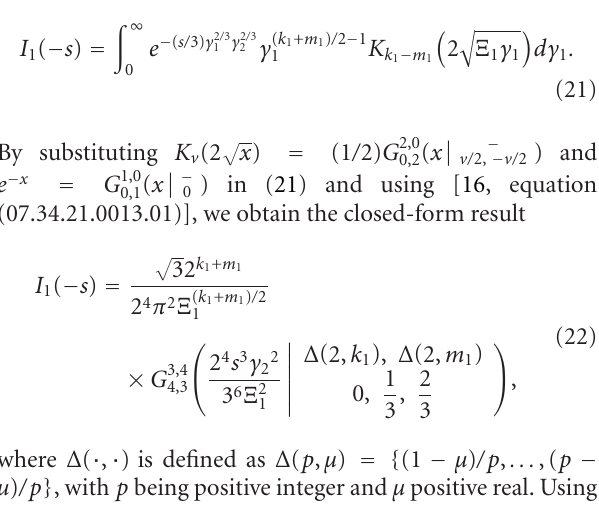
Figure 2: Average SER for 4-PSK versus average SNR per hop for N = 1 and N = 2 dual-hop links with MRC assuming m 0 = 1, k 0 = 0 . 5 for the direct link, m 1 = 1, k 1 = 1 . 5 for the first relay link, and m 2 = 2, k 2 = 3 for the second relay